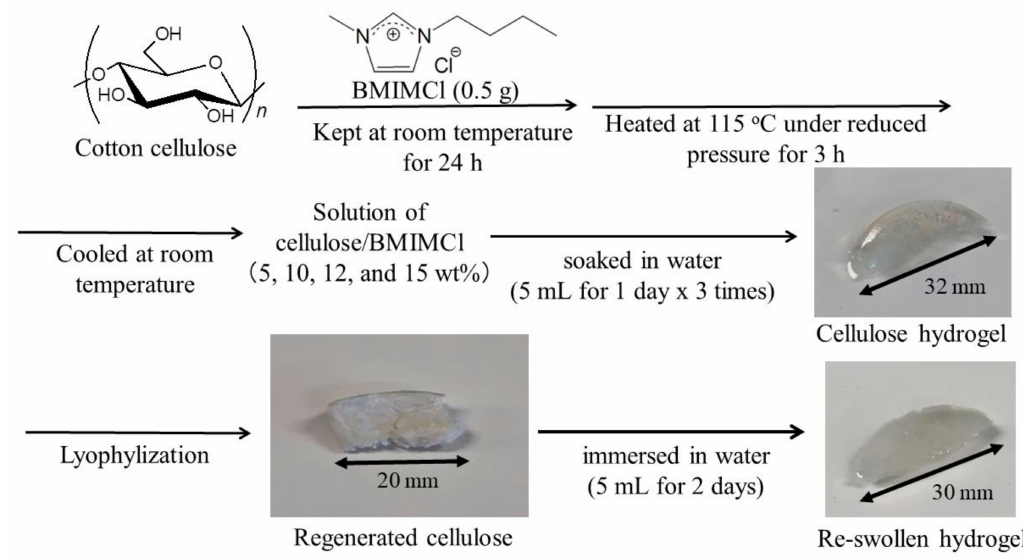
Figure 1. Procedure for the fabrication of amorphous porous celluloses through hydrogelation from solutions with 1-butyl-3-methylimidazolium chloride (BMIMCl) and their reswelling